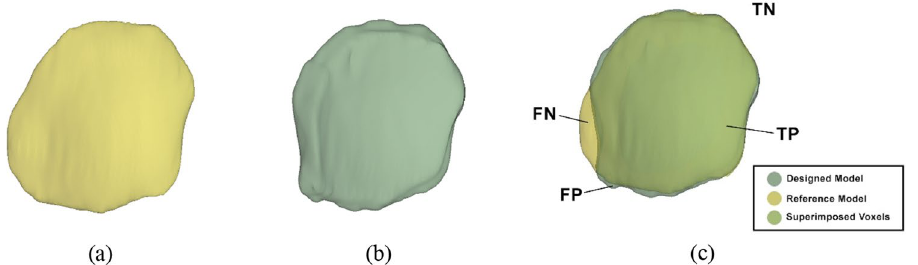
Figure 10. Implant model designed by ( a ) neurosurgeon, i.e., the reference defect model, ( b ) mirror-based method and ( c ) overlay of the designed and reference models. It should be noted that any voxels located outside both the designed and reference are defined as healthy